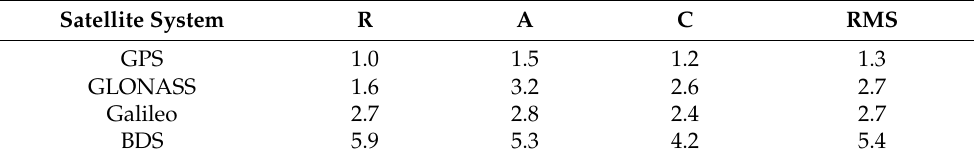
Table 3. Accuracy statistics of multi-GNSS orbit using the non-parallel method (cm).